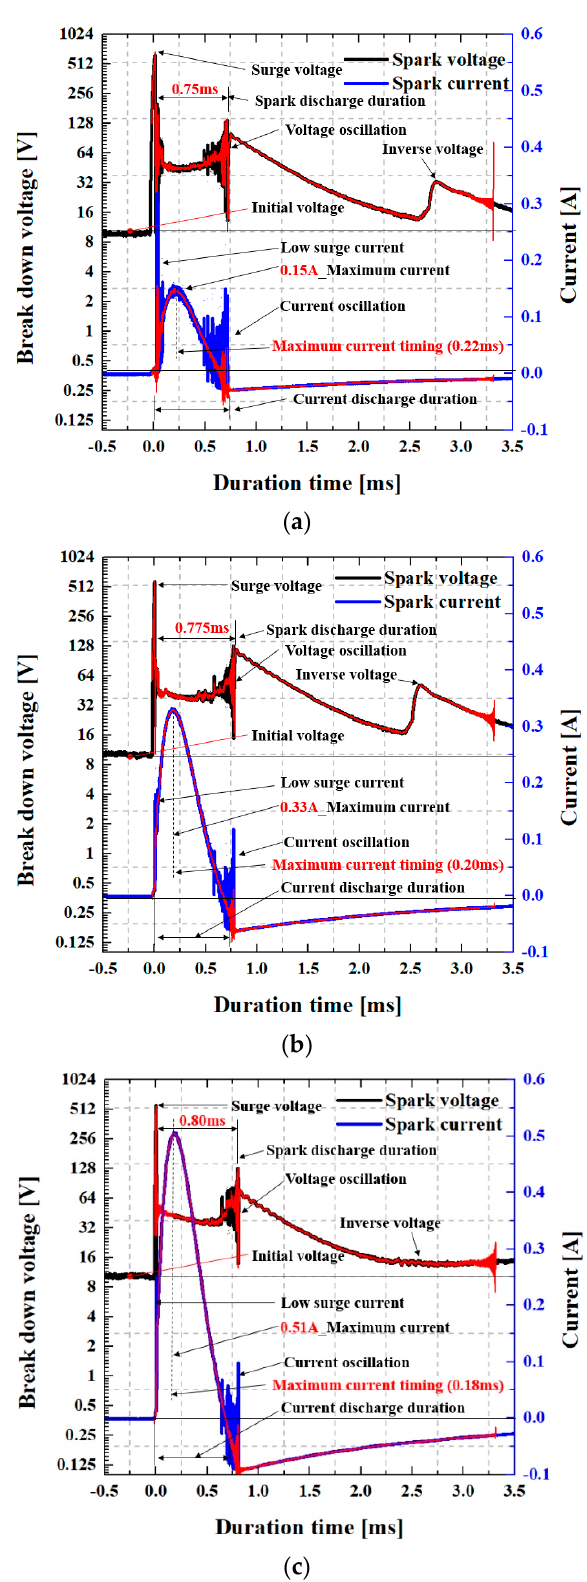
Figure 6. Voltage and current of the conventional spark system: ( a ) 50 V initial voltage of the conventional spark; ( b ) 100 V initial voltage of the conventional spark; ( c ) 150 V initial voltage of the conventional spark.